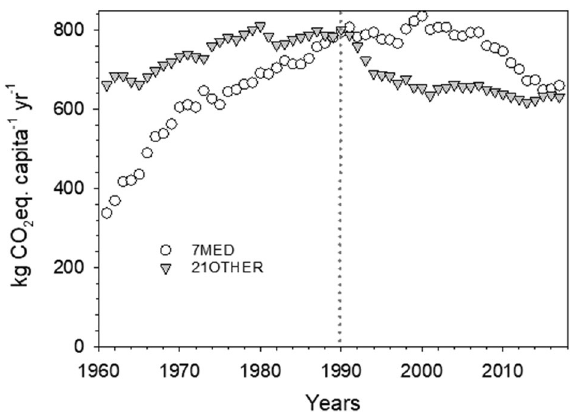
Figure 3. Annual per capita GHG emissions associated to meat consumption in European countries from 1961 to 2017. Total per capita yearly E GHG (kg CO2 eq. capita −1 yr −1 ) associated to apparent consumption of beef, mutton and goat, pork and poultry meat by citizen in 7MED (white circles) and 21OTHER (grey triangles) countries from 1961 to 2017.